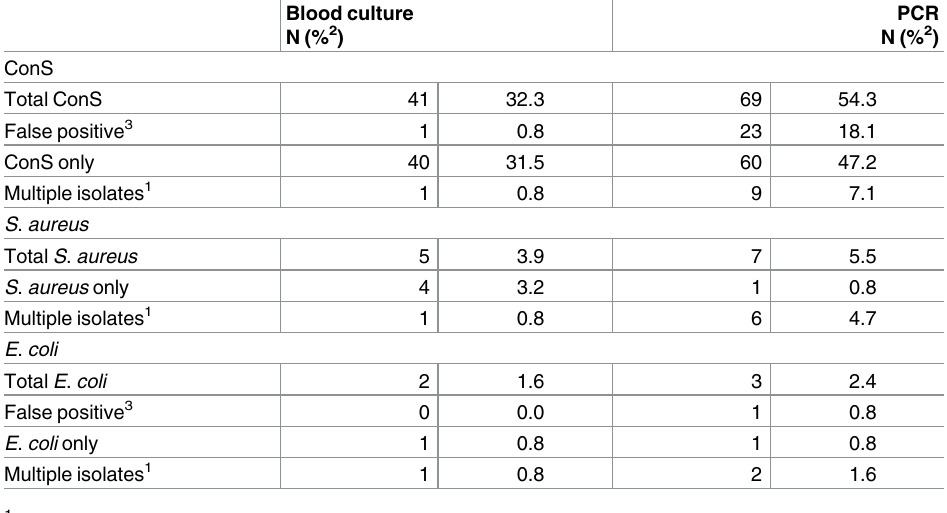
Table 5. Detection of ConS, S . aureus and E . coli , stratified by blood culture and